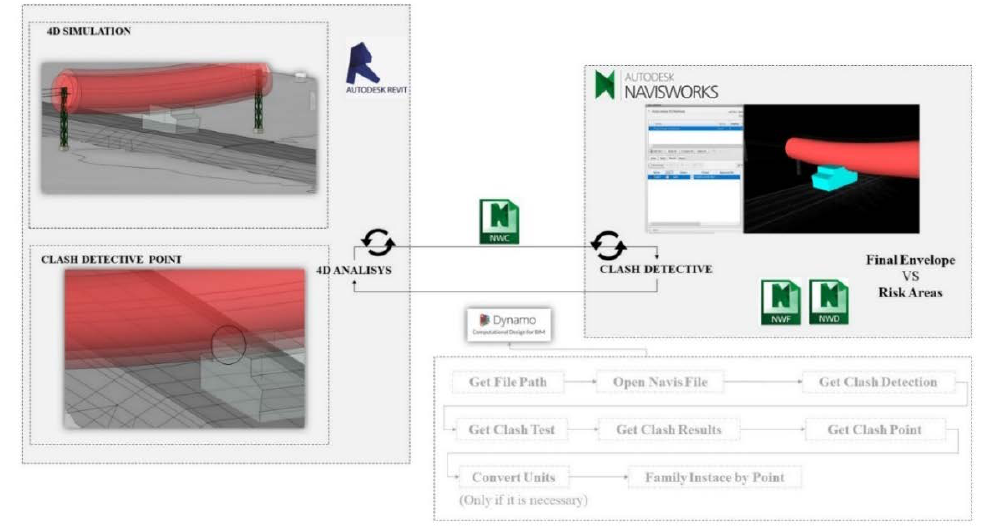
Figure 4. Collision analysis between the final envelope and hazard zone 2 in the HMA spreading phase, wearing course .